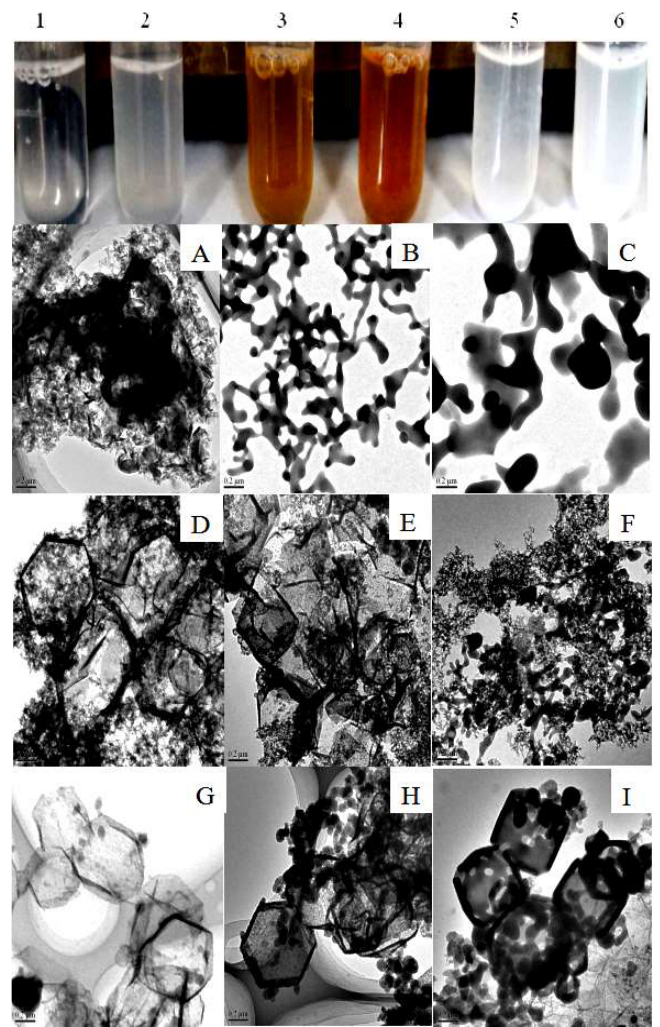
Figure 7. Appearance of CAT/ZIF-8 (1, after acid treatment; 2, before treatment), Fe 3+ -CA@CAT/ZIF-8 (3, after acid treatment; 4, before treatment), and SiO 2 @CAT/ZIF-8 (5, after acid treatment; 6, before treatment); and TEM images of CAT/ZIF-8 ( A , B , and C , acid treatment for 30, 60, 90 min, respectively), Fe 3+ -CA@CAT/ZIF-8 ( D , E and F , acid treatment for 30, 60, 90 min, respectively), and SiO 2 @CAT/ZIF-8 ( G , H and I , acid treatment for 30, 60, 90 min, respectively).